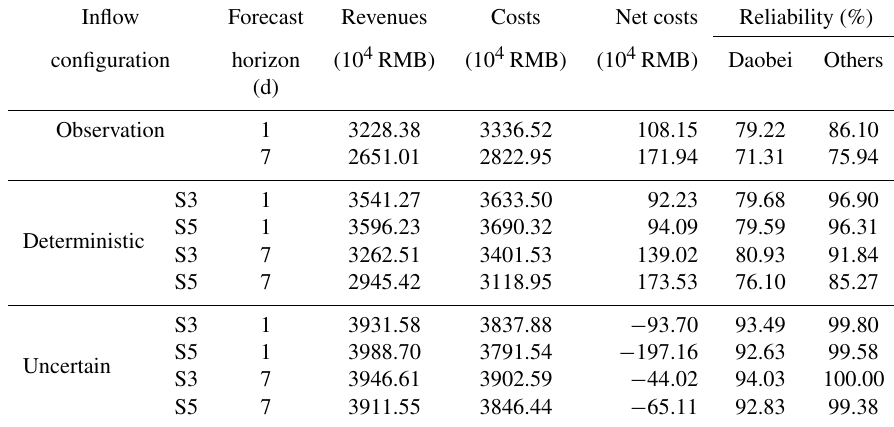
Table 6. Annual system performance using forecast inflow information.